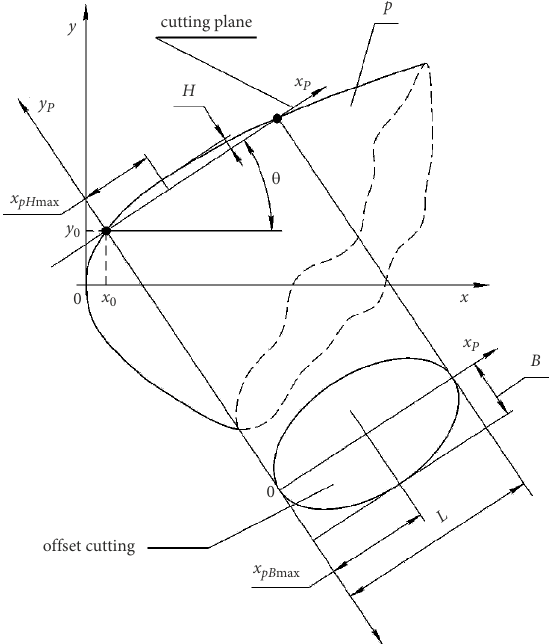
Figure 8. Diagram of elliptical cut-out from parabolic of